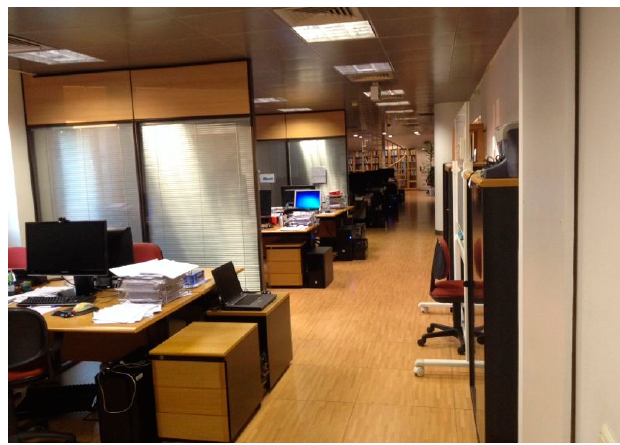
Figure 5. Workspace.